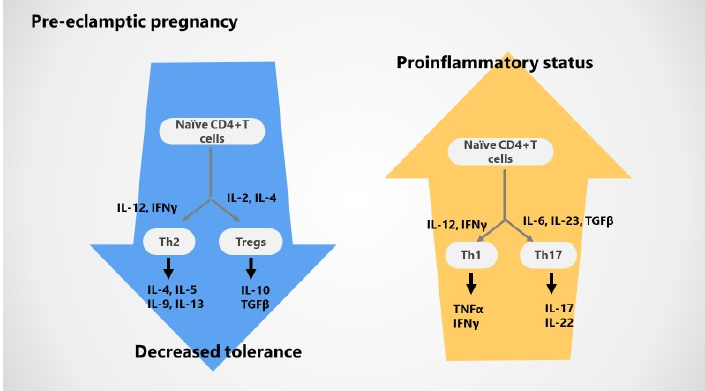
Figure 4. Immunological alterations during pre-eclamptic pregnancy; T-cell bias with Th1–Th17 versus Th2–Tregs axis and resultant cytokines disbalance: decreased maternal–fetal tolerance accompanied by excessive pro-inflammatory status.